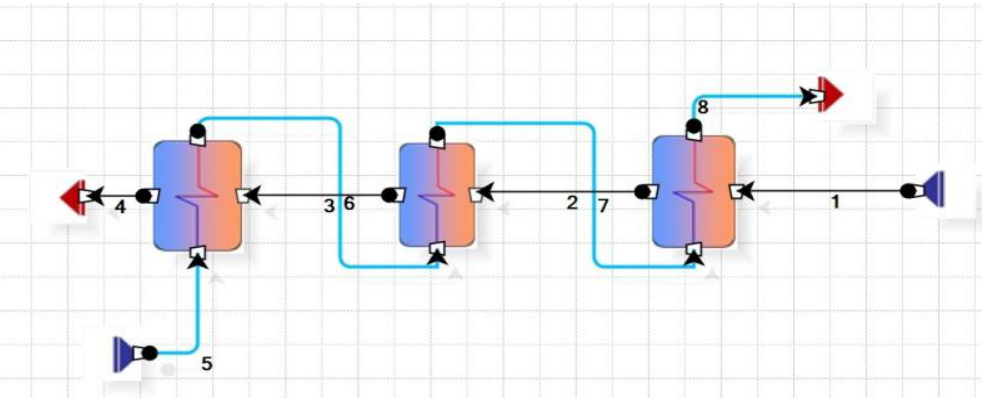
Figure 4. Separated condenser system using CAMEL-Pro